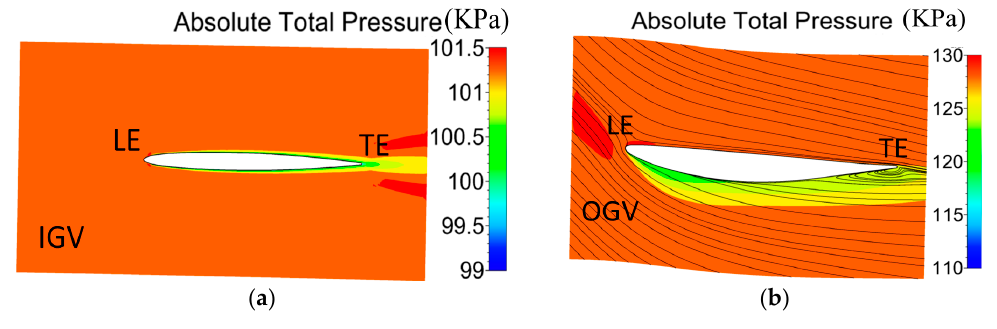
Figure 5. Absolute total pressure contours on the 90% blade span of IGV and OGV at the near-stall point: ( a ) IGV; and ( b ) OGV.